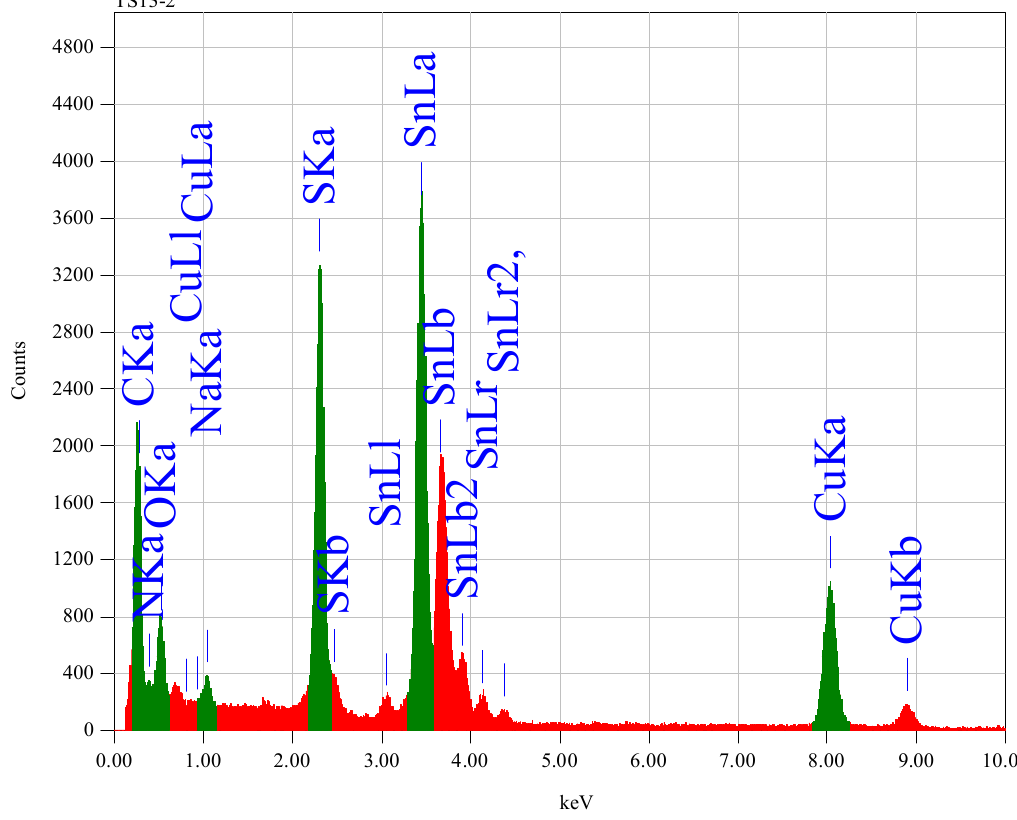
Figure 4. Energy dispersion X-ray spectrum (EDX) for SnS nanoparticles prepared in the presence of 6 mL TEA at room